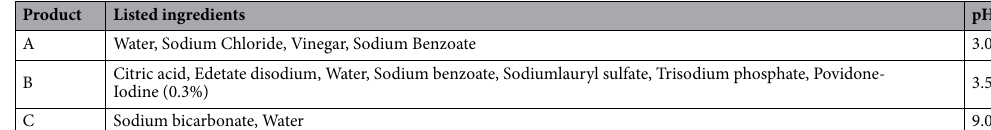
Table 1. Ingredients and pH of douching agents tested.